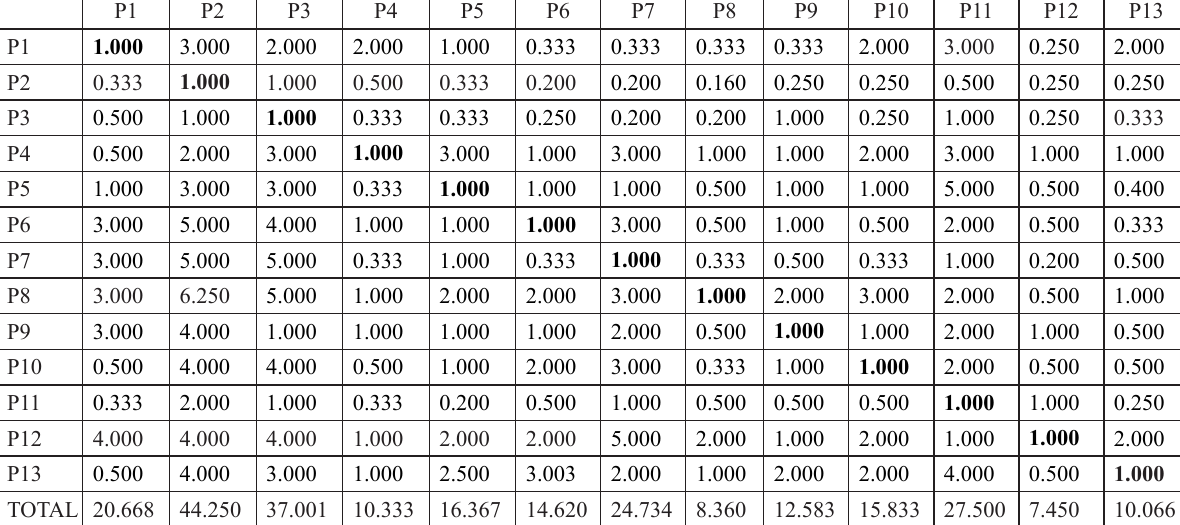
Table 1. Initial matrix of the problem pair comparison with AHP method